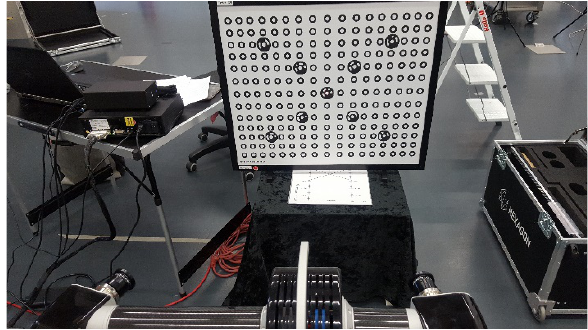
Figure 4. Calibration plate for the structured light